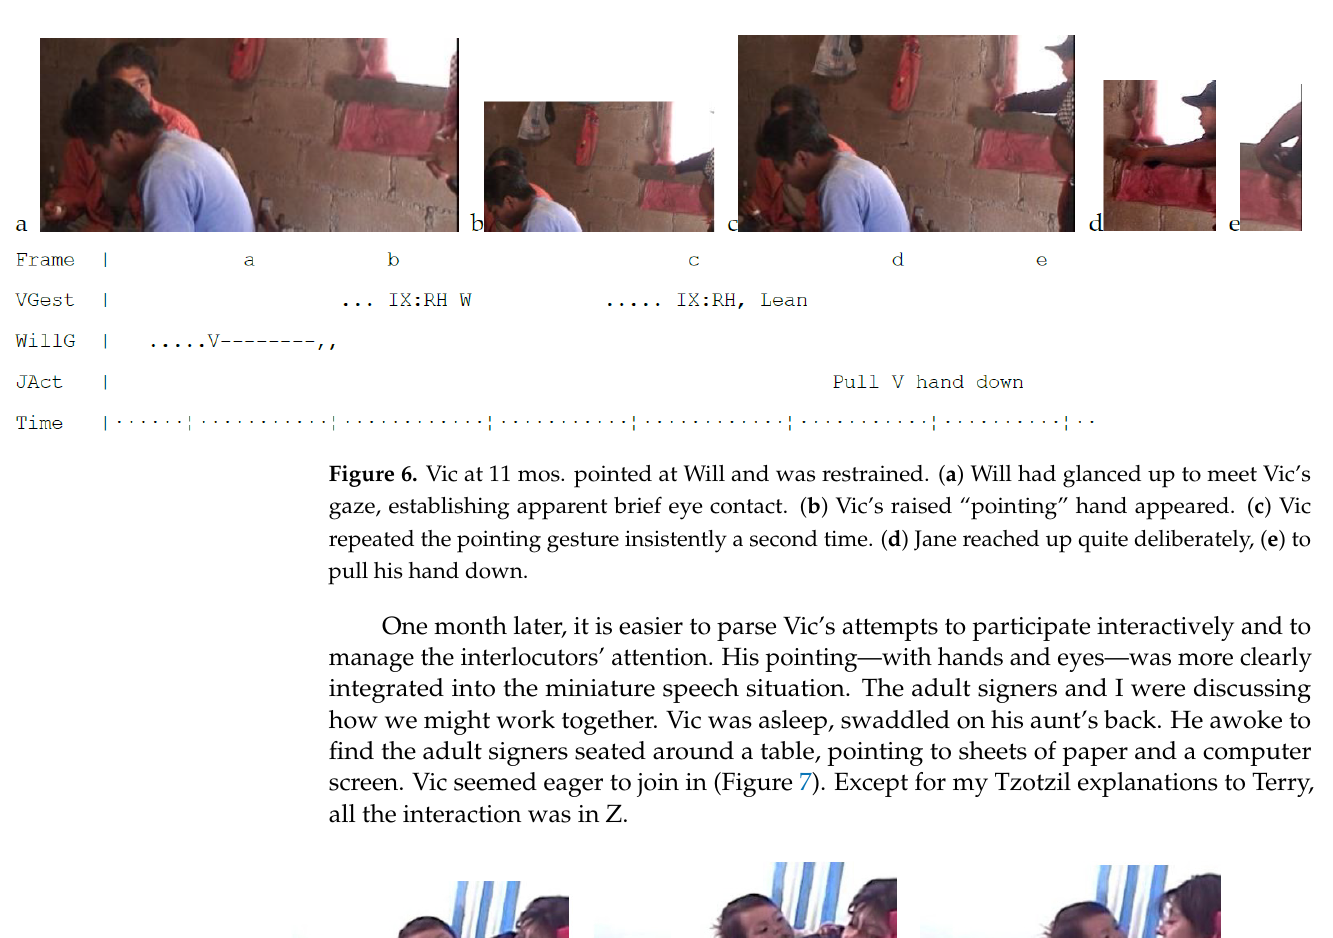
Figure 7. Vic at 12 mos. called for attention by sound, touch, and gaze. ( a ) Vic sought the visual attention of his aunt, although it never became clear what “content” he might want to convey other than getting her to attend to him. Vic moved from staring at his uncle Frank, ( b ) to turning his gaze to Terry and placing his hand on her shoulder, and then ( c ) engaging in a mutual gaze with Terry when she turned to look at him.